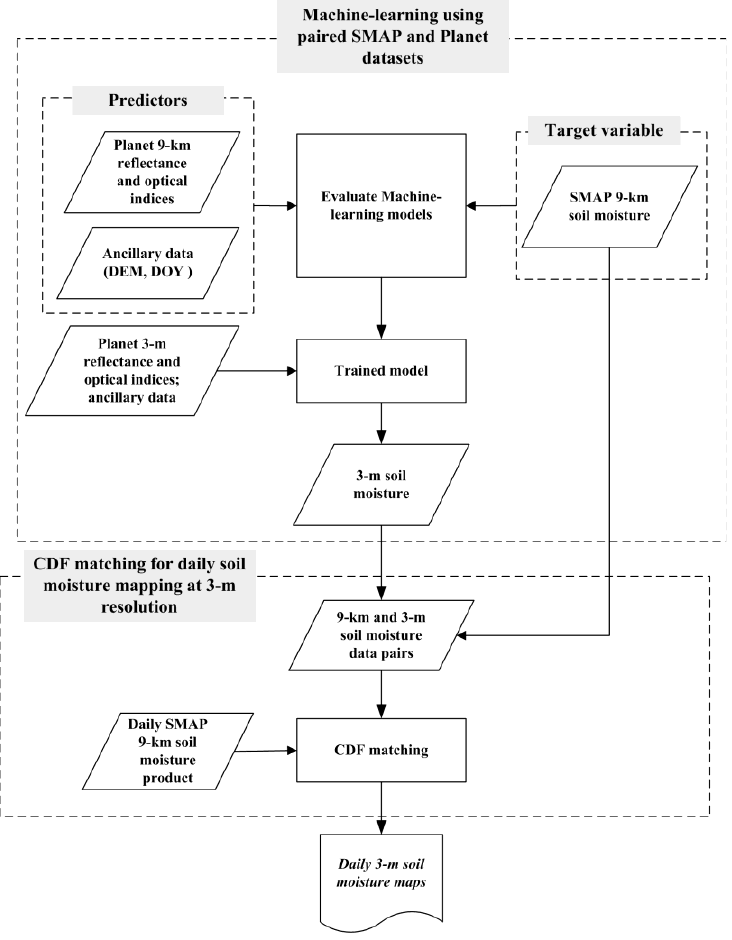
Figure 2. Algorithm flow chart illustrating the proposed downscaling approach for generating 3-m SSM maps based on multi-sensor data fusion, ML, and CDF matching techniques.